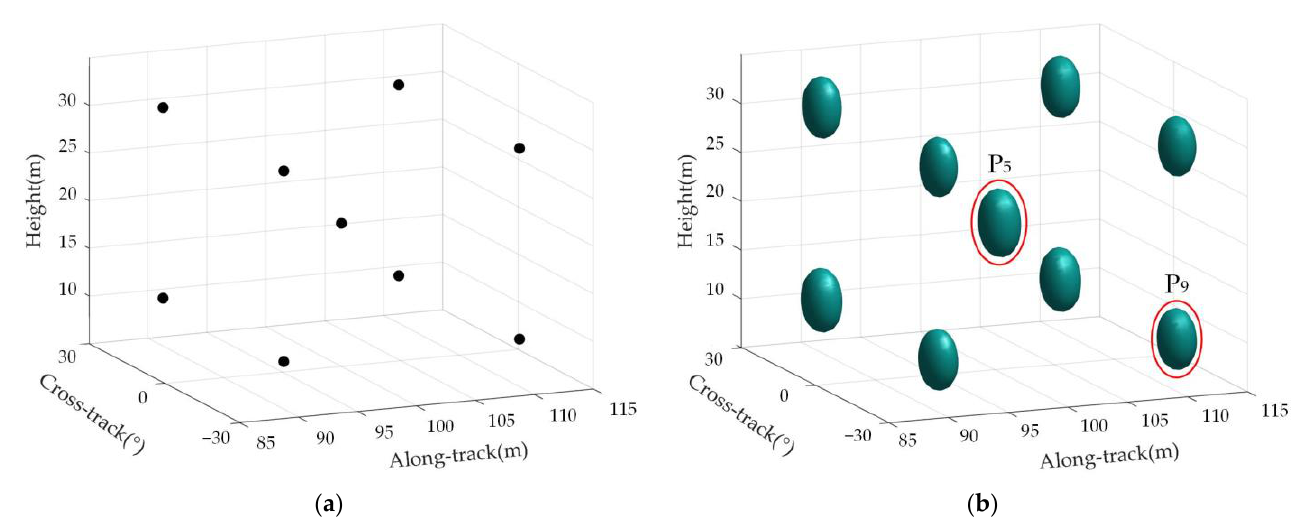
Figure 8. Multi-point target position and the imaging result of targets. ( a ) Multi-point target distribution location map; ( b ) 3D imaging results of multi-point targets.